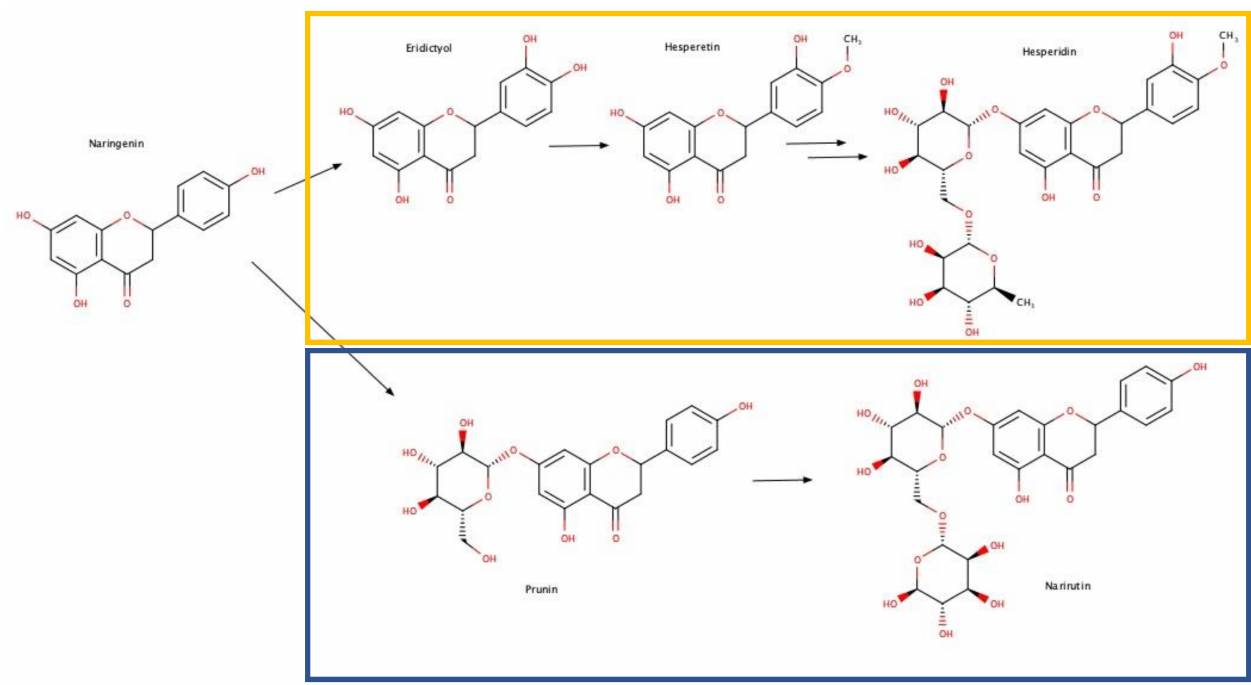
Figure 6. Biosynthetic pathway from naringenin to hesperidin through eriodictyol and hesperitin. The aglycone is then glycosidated with glucose and rhamnose. In a similar sequence, intact naringenin is glycosidated two times; first, to form prunin, which is later glycosidated by the 6-O-rhamnosyl transferase to form